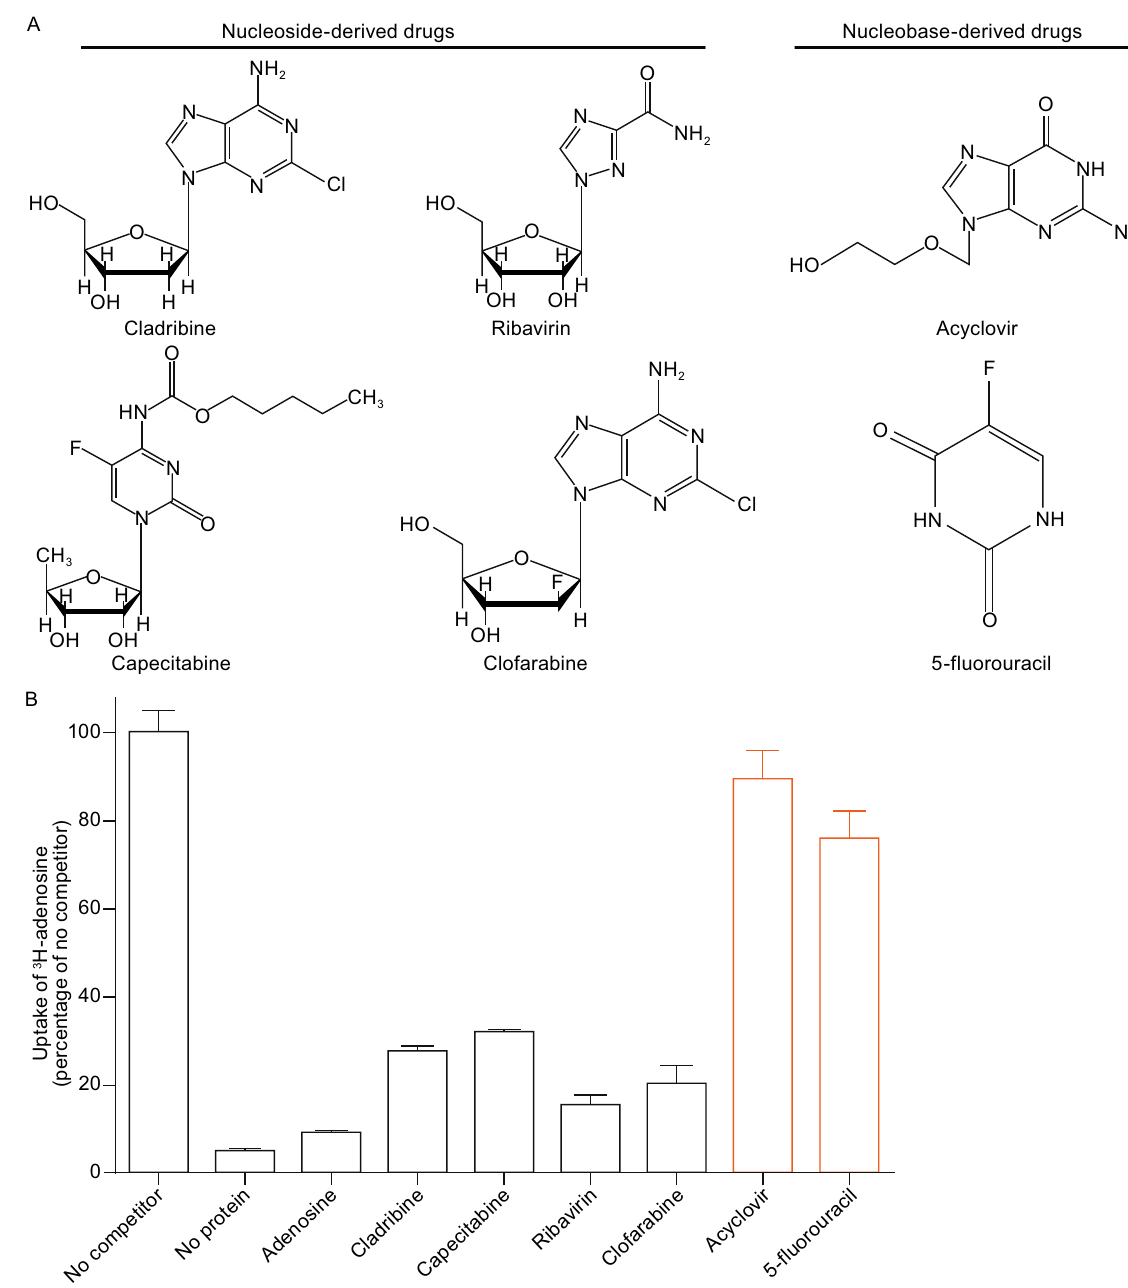
Figure 5. Nucleoside-derived drugs inhibit the transport activity of hENT1. (A) Chemical structures of representative nucleoside-derived and nucleobase-derived drugs. The drugs were used to treat cancer and virus infection in the clinic. (B) Transport activity of hENT1 for nucleoside-derived and nucleobase-derived drugs. No competitor refers to the condition where no other substrate was added. No protein refers to the condition where protein-free liposomes were used. The black boxes represent the transport activity of nucleoside-derived drugs for hENT1, whereas the orange boxes represent the transport activity for nucleobase- derived drugs. Each data point represents the average of at least three independent experiments. The error bars represent standard deviation